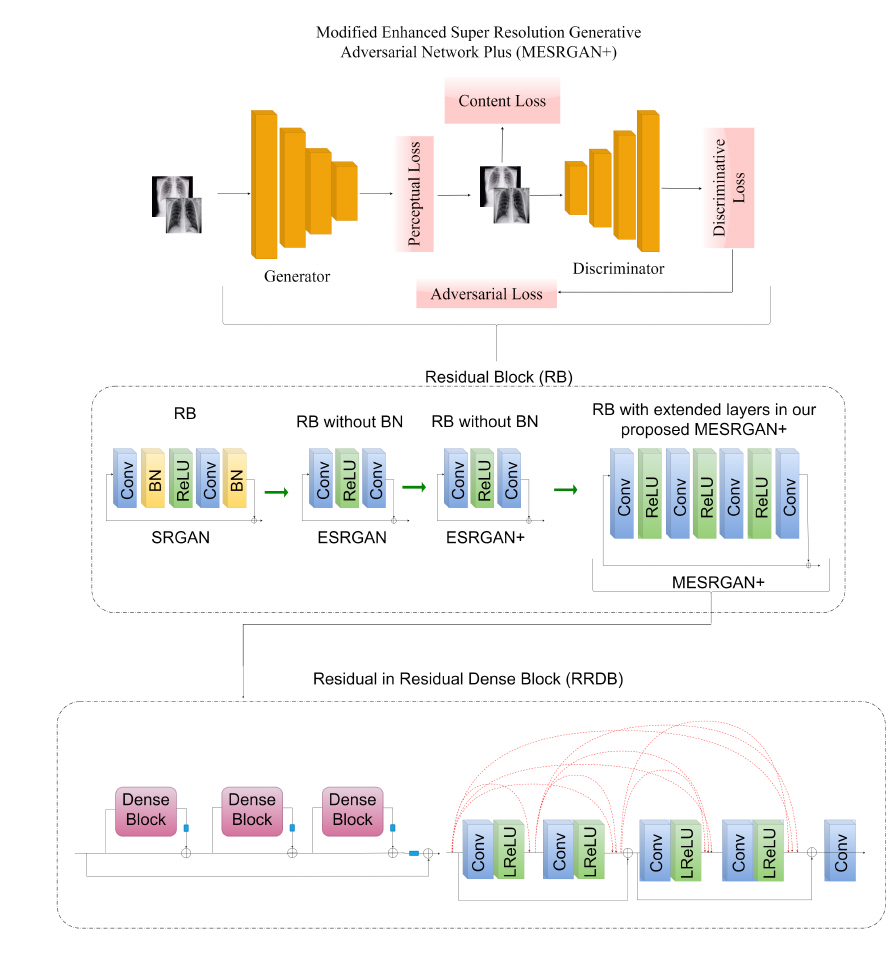
Figure 3. We adopted the fundamental structural configuration of ESRGAN+, where feature extrac- tion and most computation is performed on the LR image feature. We redesigned the structure for better optimization and performance by making a few modifications to the generator structure. The transition from SRGAN to MESRGAN+ is equally